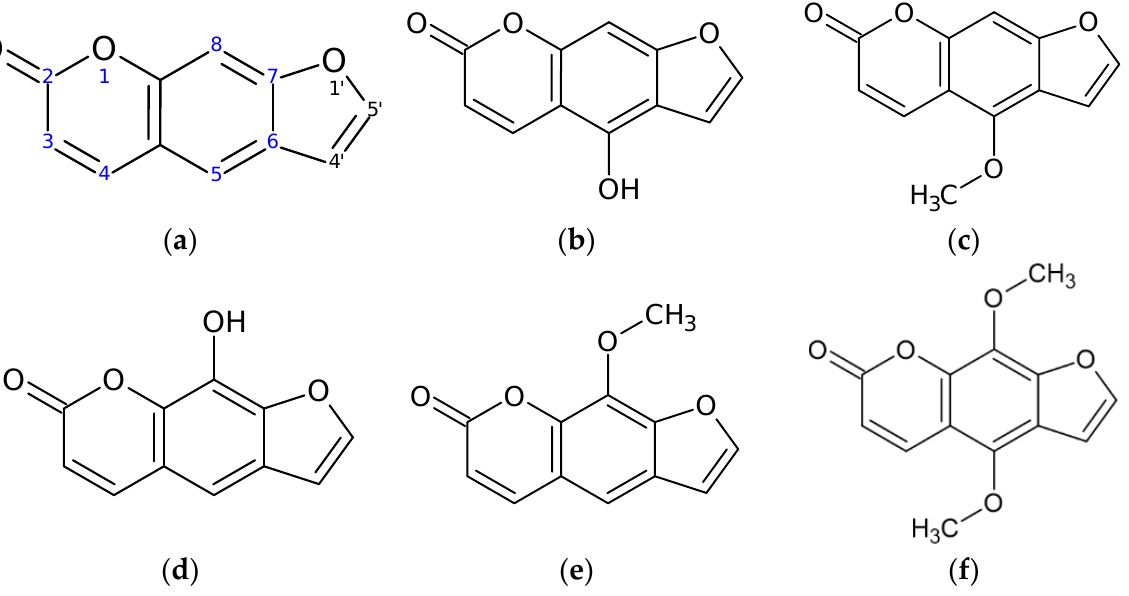
Figure 1. Structure of psoralen derivatives. ( a ) Psoralen, ( b ) 5-hydroxypsoralen (bergaptol), ( c ) 5-methoxypsoralen (bergapten), ( d ) 8-hydroxypsoralen (xanthotoxol), ( e ) 8-methoxypsoralen (xanthotoxin), and ( f ) 5,8-dimethoxypsoralen (isopimpinellin).